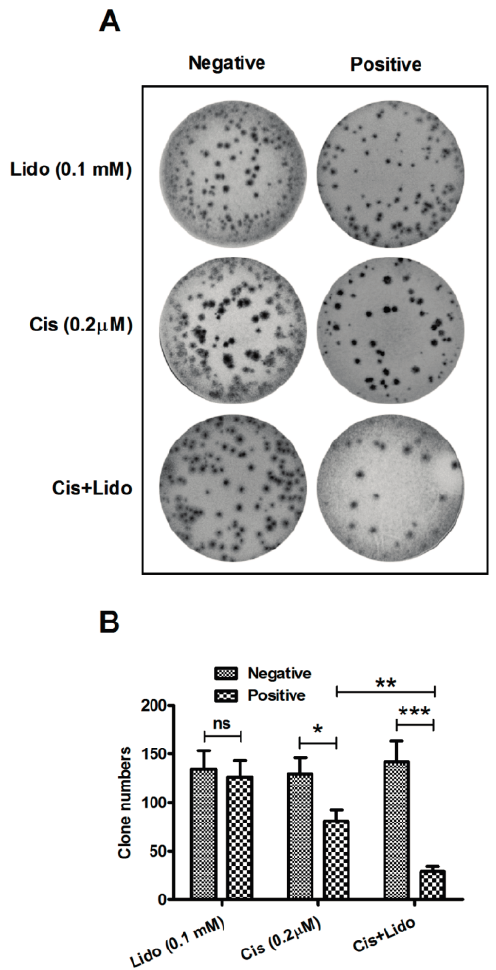
Figure 4. Colony formation of MCF-7 cells treated with lidocaine and/or cisplatin. ( A ) Colony formation of MCF-7 cells post the transfection with 0.2 μ M cisplatin, 0.1 mM lidocaine or with both agents for 96 h; ( B ) The colony number in groups with or without the treatment of 0.2 μ M cisplatin and/or 0.1 mM lidocaine. All experiments were performed independently in triplicate. Statistical significance was shown as * p ˂ 0.05, ** p ˂ 0.01, or *** p ˂ 0.001, ns: no